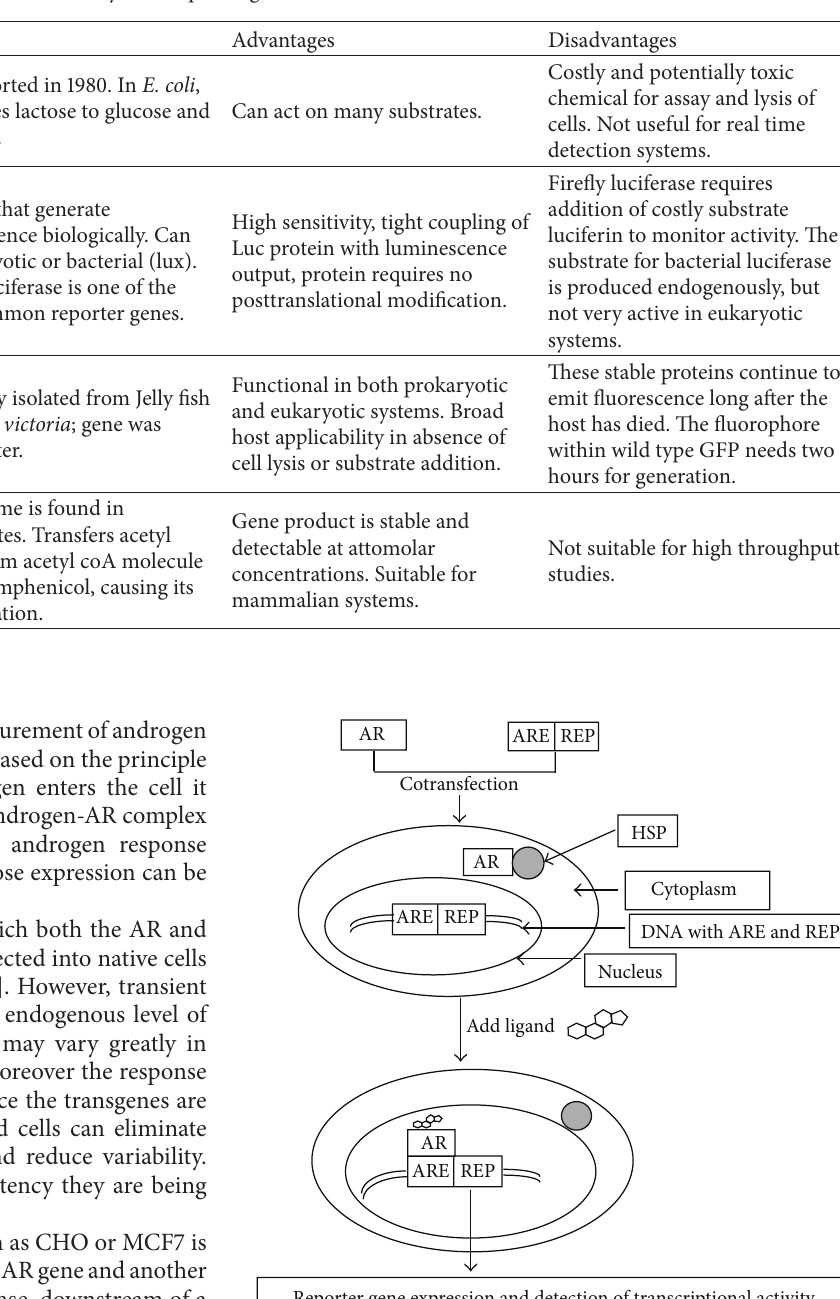
Table 2: Commonly used reporter genes and their characteristics.